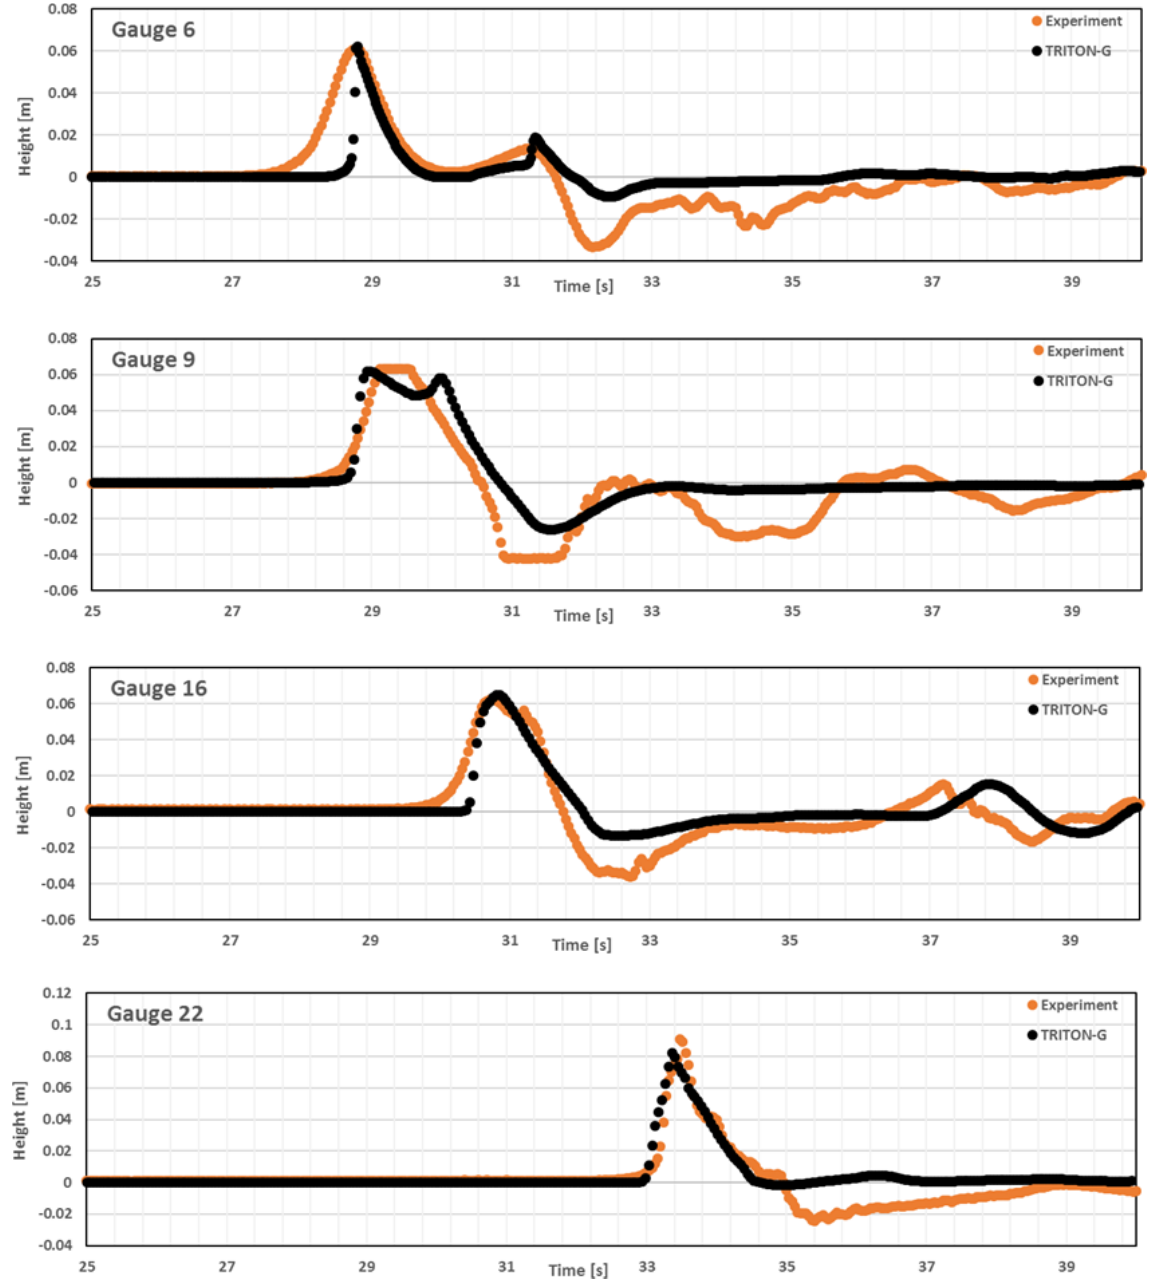
Figure A9. Comparison between computed and measured water levels at gauges 6, 9, 16 and 22 for case C ( H = 0 .